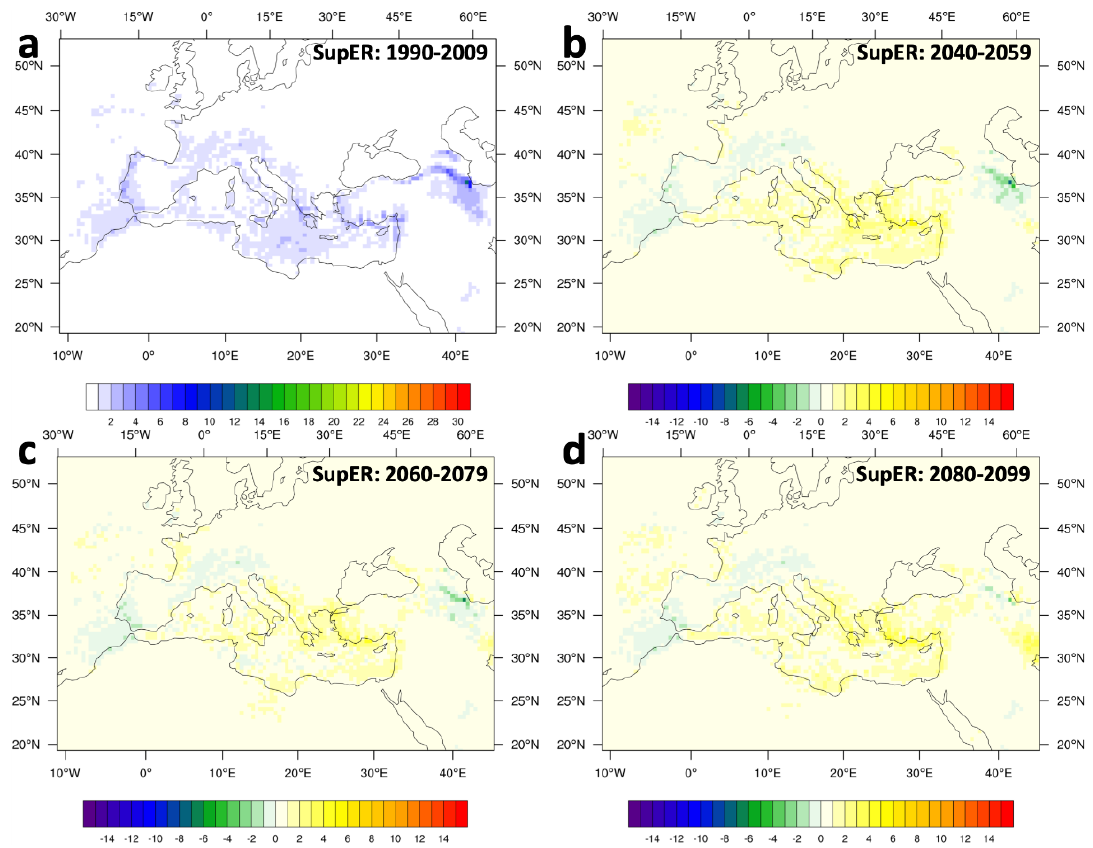
Figure 9. ( a ) Annual average number of days with CAPE ≥ 100 J / kg AND 0–6 km SHEAR ≥ 20 m / s AND convective precipitation rate > 0 mm / h (SupER) for 1990–2009, ( b ) changes in average number of days with SupER for 2040–2059, ( c ) changes in average number of days with SupER for 2060–2079, ( d ) changes in average number of days with SupER for 2080–2099.